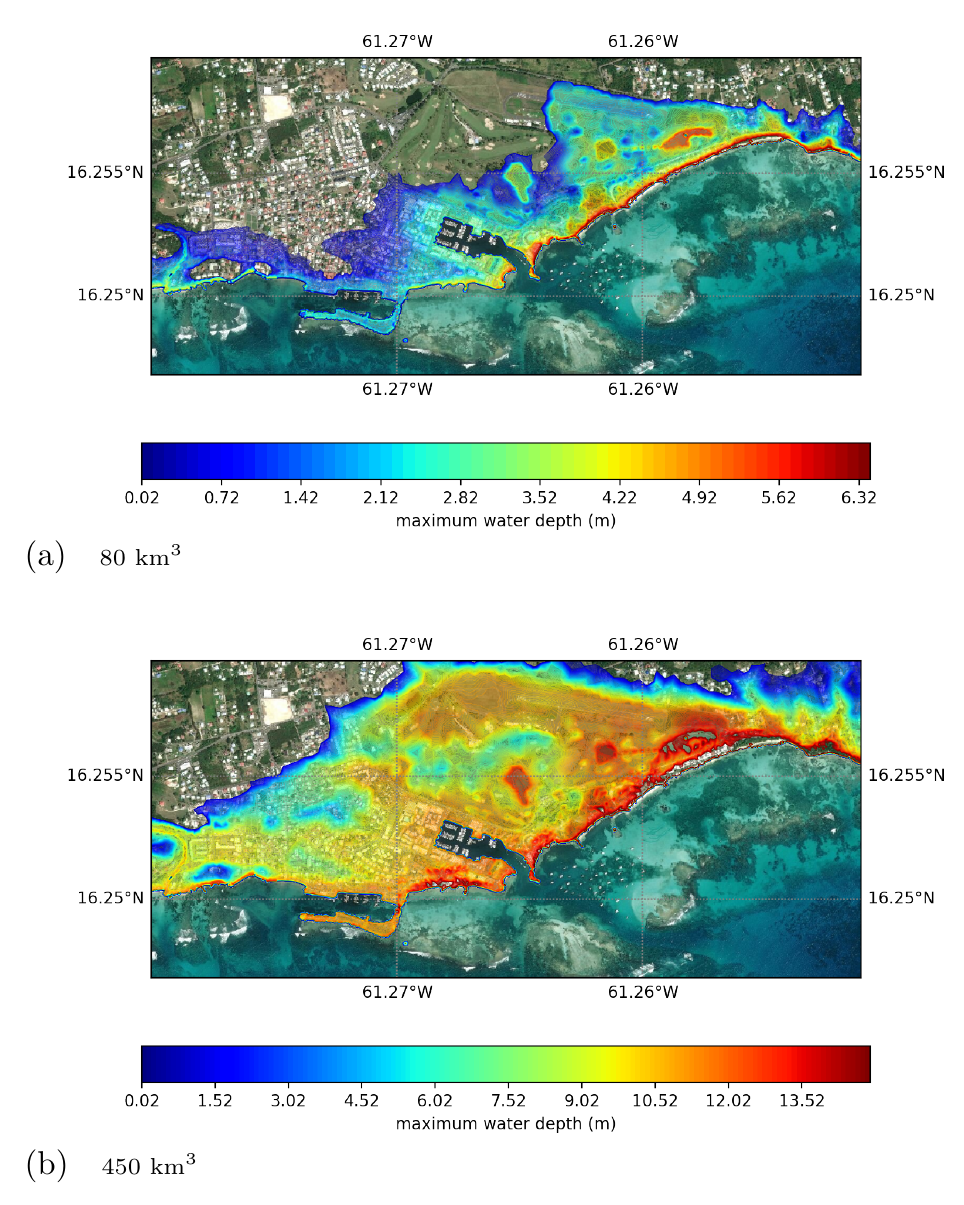
Figure 7. Maximum water depth in the area of Saint-François, Grande-Terre for the 80 and 450 km 3